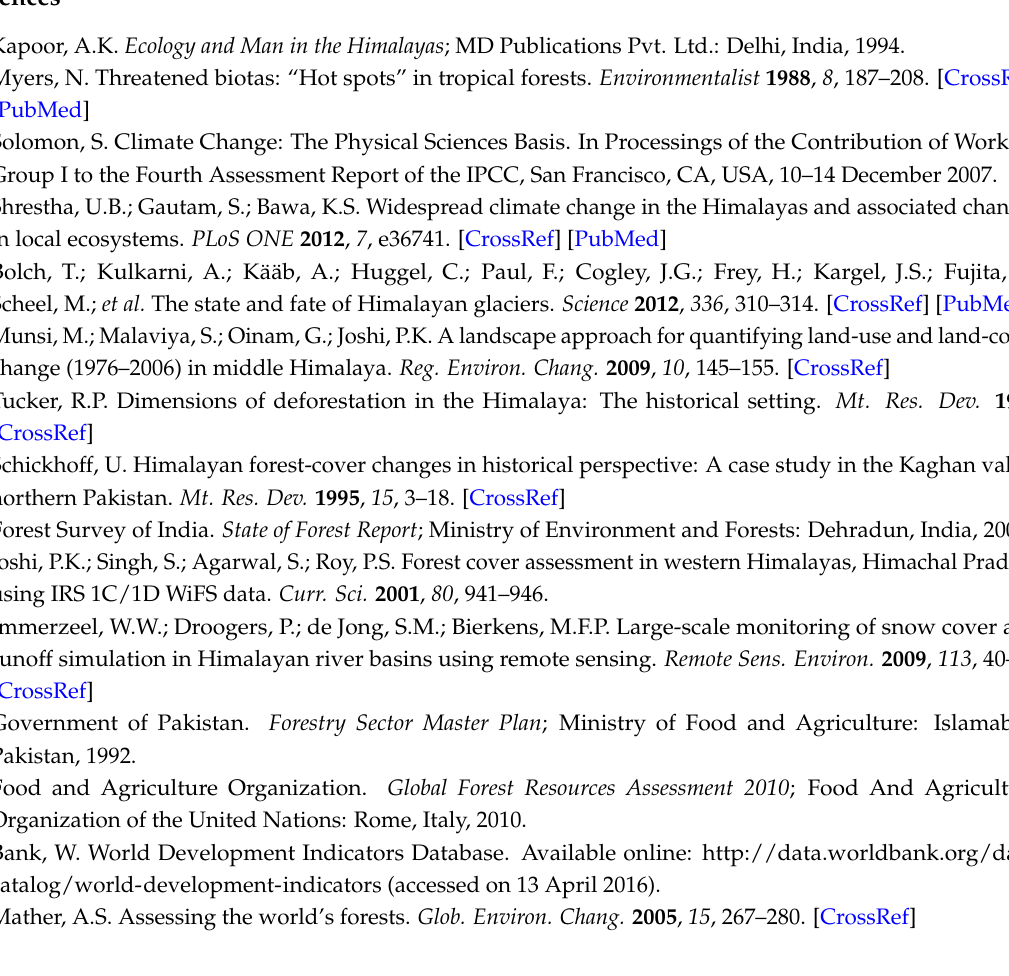
Table S1: List of satellite data used, S1: Summary of decisions for improving the interpretation of land cover, Tables S2–S7: Land cover change matrix, S2: Comparison with other studies in the area. Table S8: Comparison of current assessment with global assessment [1]. Tables S9–S11: Comparison of current assessment with previous national assessment [2] for Khyber Pakhtunkhwa (KP) including FATA, Gilgit-Baltistan (GB), and Azad Jammu and Kashmir